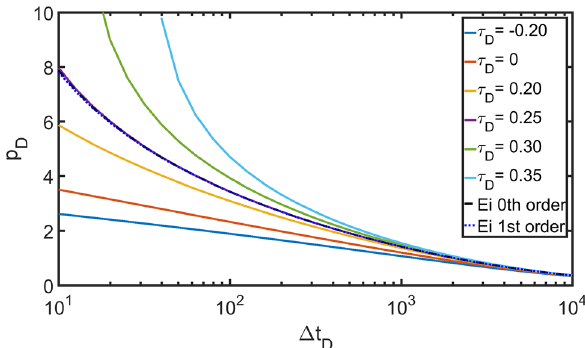
Fig. 2 MDH plot, Infinite-acting radial